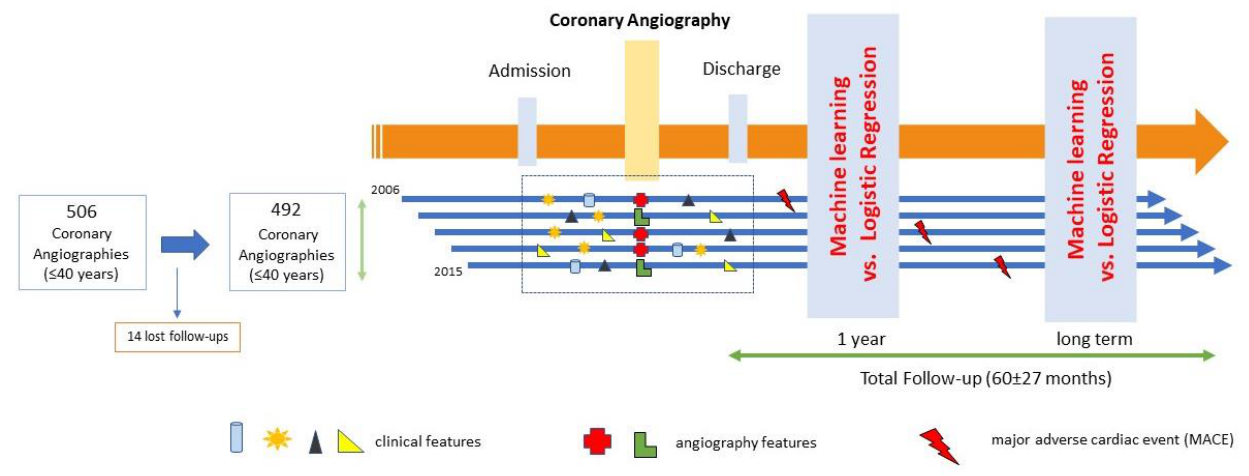
Figure 1. Study flow chart.